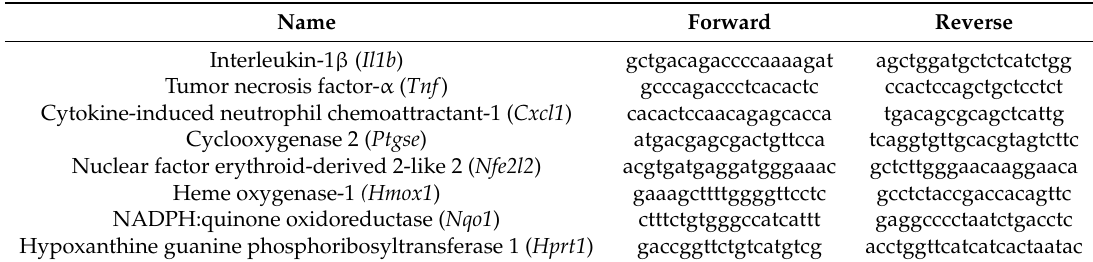
Table 1. Sequences of the primers used to analyze gene